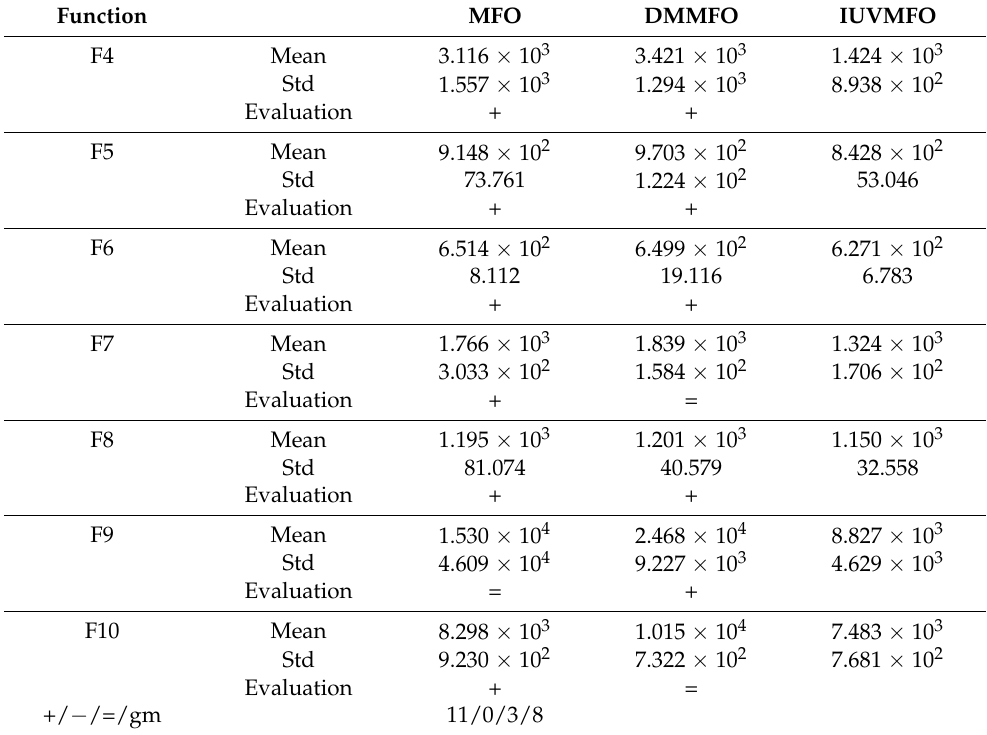
Table A4. Statistics of 50-dimensional Function Test Results.